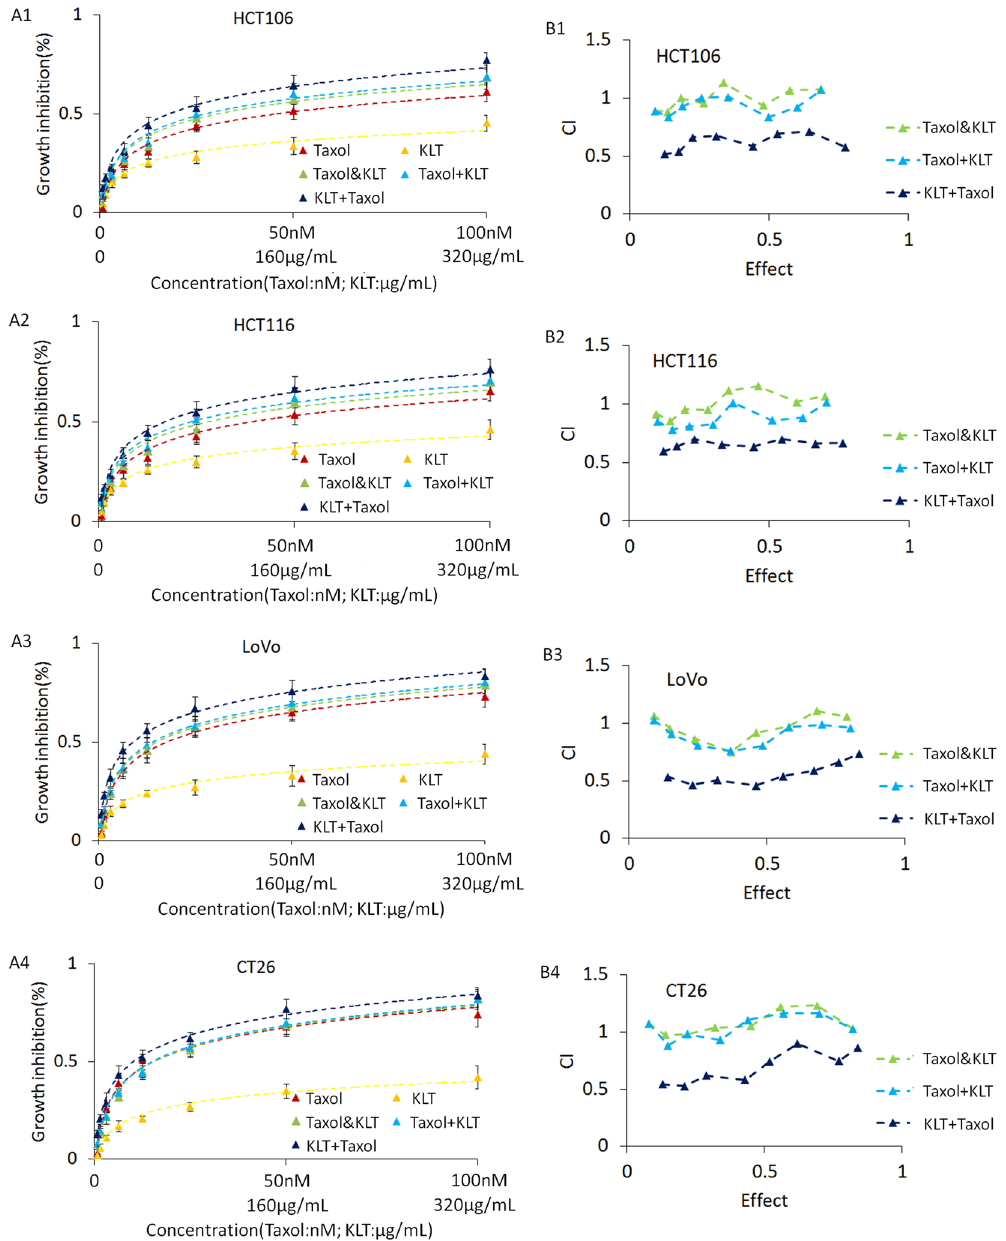
Figure 1. Results of MTT assay and CalcuSyn software analysis for four colorectal cancer cell lines. The groups are defined in “Kanglaite and Taxol treatment”. ( A ) MTT assay results of two agents and three different treatment combinations. Vertical coordinate represents growth inhibition rate, which is compared with that of untreated cells. Horizontal coordinate represents agent concentrations: the first line is Taxol concentration (nM), the second line is KLT concentration ( μ g/mL). Points represent the mean from three independent experiments and bars represent standard deviations. ( B ) CalcuSyn software analysis of the MTT assay results. “CI” - combination index. CI > 1 represents antagonistic cytotoxicity; CI = 1 represents addictive cytotoxicity; CI < 1 represents synergistic